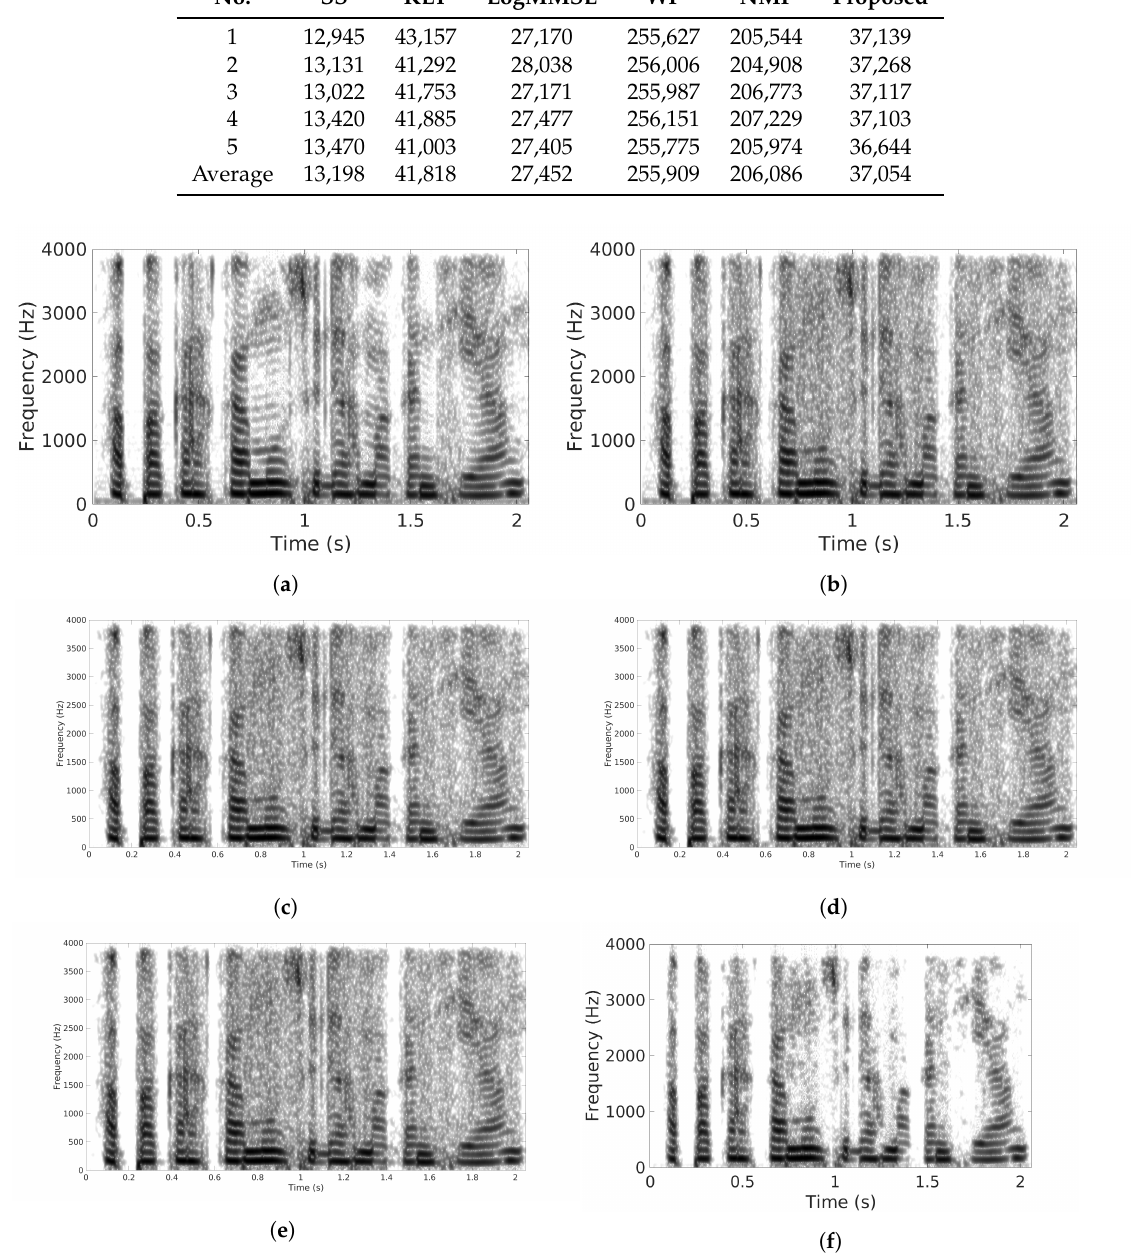
Figure 9. The spectrogram of male speakers: “apakah kamu sudah makan siang.” of ( a ) the original speech, ( b ) the decrypted speech from PCM and the enhanced speech from ( c ) SS + IMCRA, ( d ) SS + Martin, and ( e ) SS + Hirsch, and ( f ) the proposed